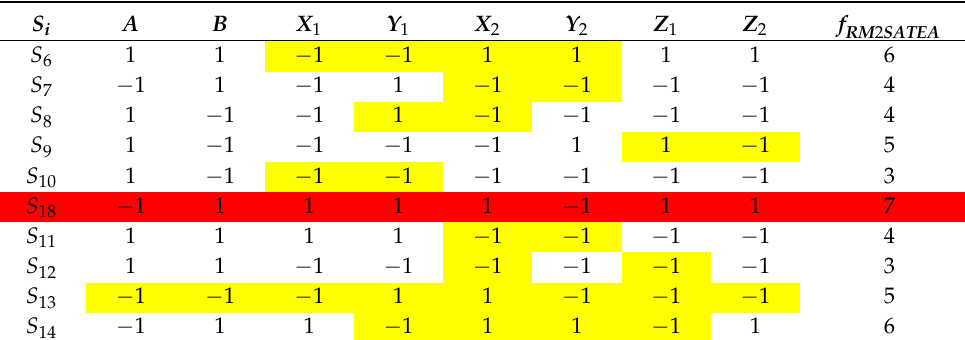
Table A14. Coalition of Party 2 and Party 3.